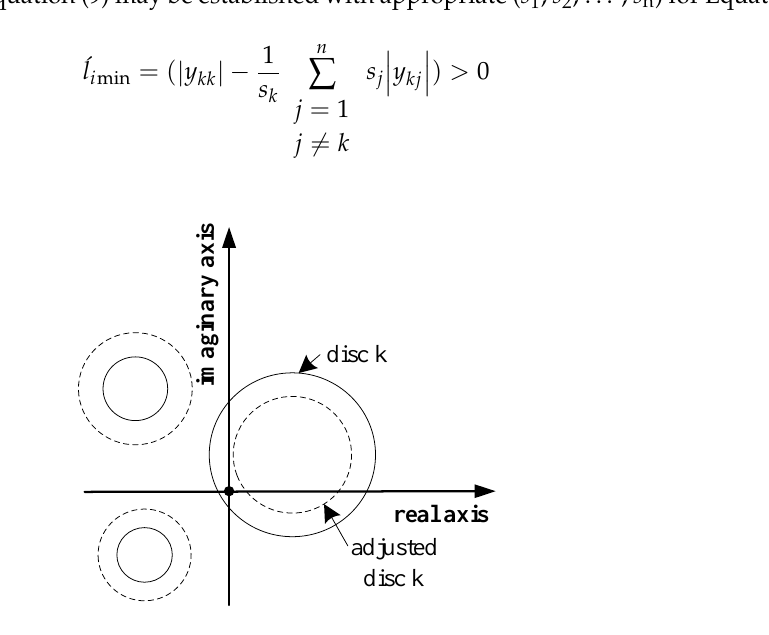
Figure 3. Change of disc k by matrix similar transformation.